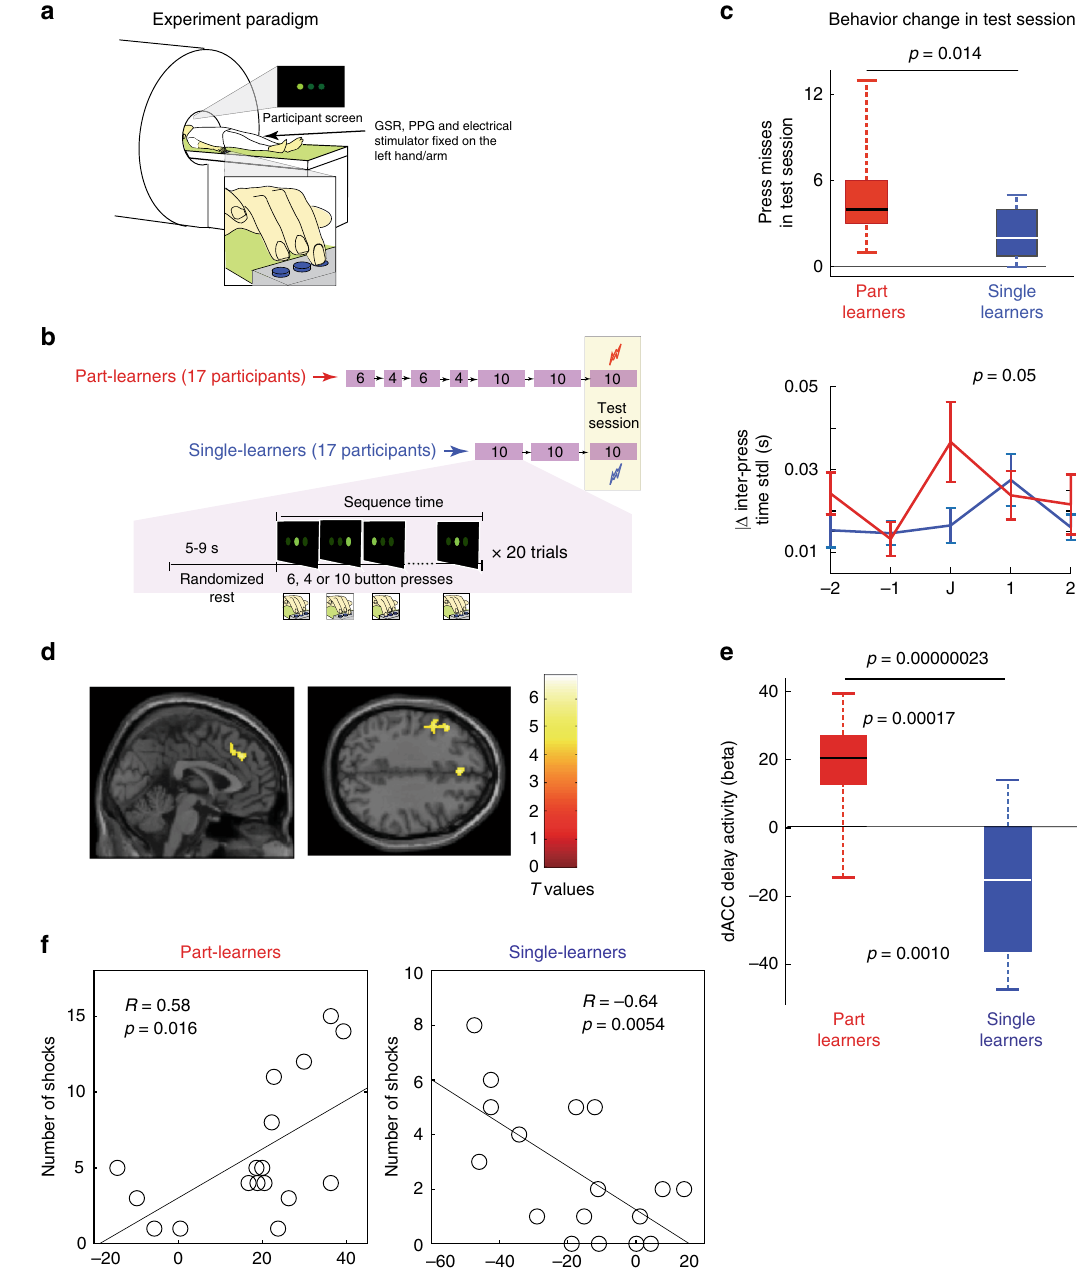
Fig. 2 Experiment 2: a The participants lay in an fMRI scanner and performed a sequential button-press task in which they pressed three buttons in a sequence guided by a visual cue on the screen above them. b Each participant worked as either a part learner or single learner in sessions of 20 trials as shown. c The number of press misses are shown in the top panel with boxplots. The bottom panel shows the absolute change in the inter-press time standard deviation (STD) near the junction in the anxiety test session. Error bars show standard error. d A parametric event-related general linear model analysis was conducted in which the seventh button in every trial was de fi ned as the junction event, and the inter-press time in every trial at the junction was used as the parametric regressor and contrasted between the part- and single learners. A two-sample t -test demonstrated that activity in the dACC (peak MNI coordinates, [0, 36, 36]) and left and dorsal premotor cortices (peak MNI coordinates, [ − 48, 8, 42]) was signi fi cantly higher in part learners than in single learners ( p < 0.05, family-wise-error (FWE) corrected). We used p < 0.0005 uncorrected for display purposes here. e The beta values for part learners were positive ( p = 0.00017, one-sample t -test), while those for single learners were negative ( p = 0.00010, one-sample t -test), and these values were signi fi cantly different ( p = 0.00000023, two-sample t -test). f The relationship between differential brain activity and the number of electrical shocks. dACC activity was positively correlated with the number of electrical shocks in part learners (left, R = 0.58, p = 0.016), while the correlation was negative in single learners (right, R = − 0.64, p = 0.0054). No correlation with shocks was observed in the left premotor cortex of the same part learners ( R = 0.38 and p = 0.14) or single learners ( R = 0.11 and p = 0.67). On the boxplots in c and e , the line within the box shows the median, the edges of the box are the 25th and 75th percentiles of the data, and the whiskers show the range of the data